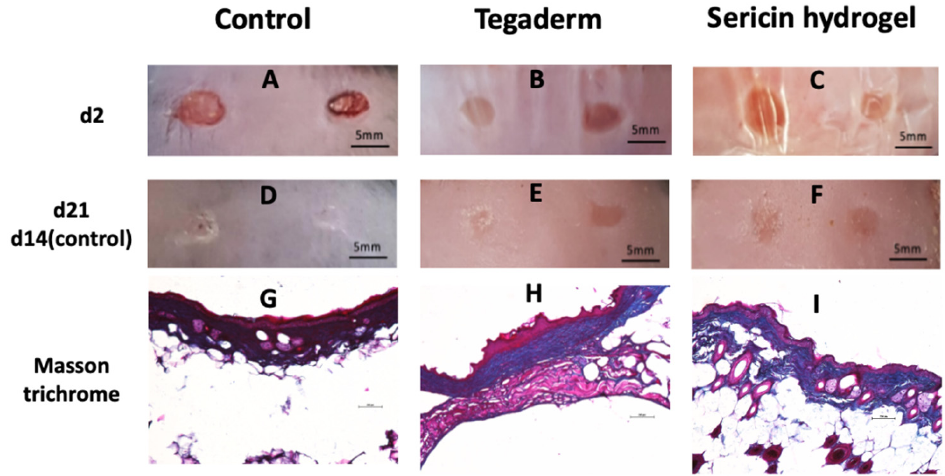
Figure 6. Representative images of wound closure ( A – F ) and histopathological analysis by Masson’s Trichrome staining ( G – I ) in a mouse model of a skin wound healing assay. The wounds were treated with sericin hydrogel and covered with Tegaderm, only covered with Tegaderm, or left untreated (control). Magnification of 200×. Scale bars = 200 μ m.